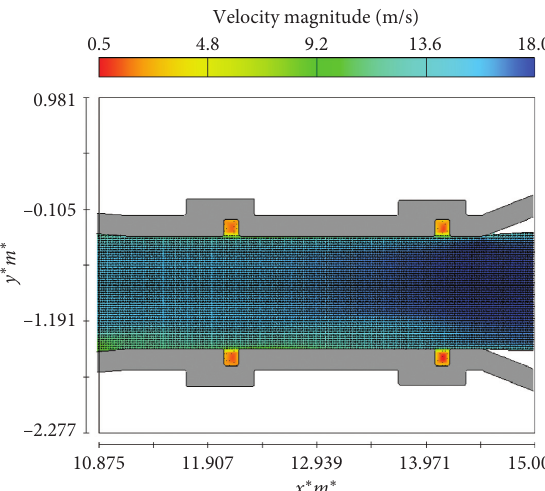
Figure 16: Velocity change’s size and vectors in the gate slots at 100% gate and valve opening.